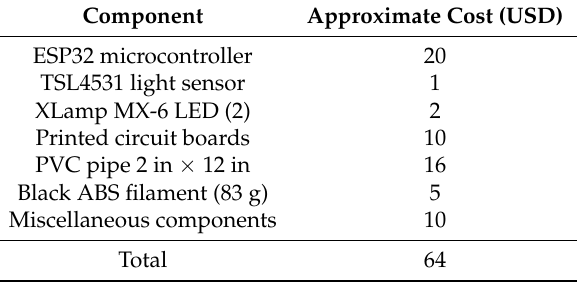
Table 2. Unit component cost of the prototype